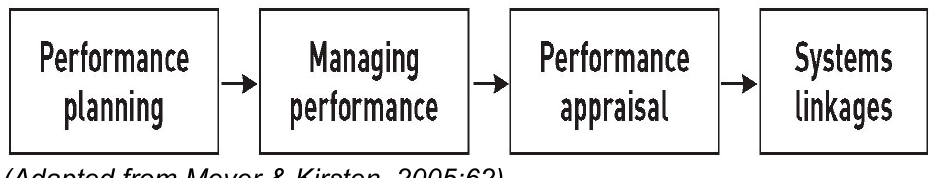
(Adapted from Meyer & Kirsten,